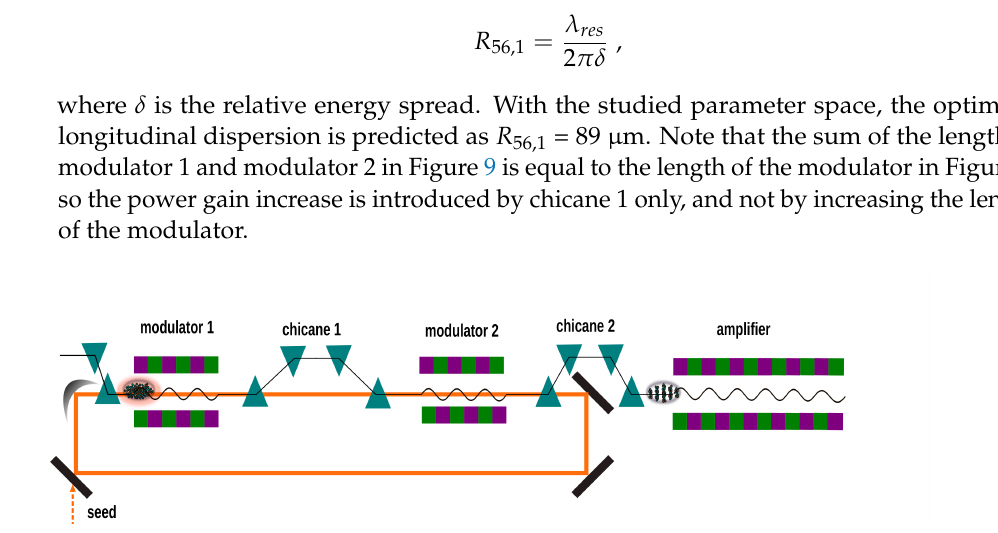
Figure 9. In an oscillator-based HGHG scheme, an optical klystron can be employed. To do so, the cavity contains two modulators separated by a chicane. This way this chicane can be tuned to control the gain per